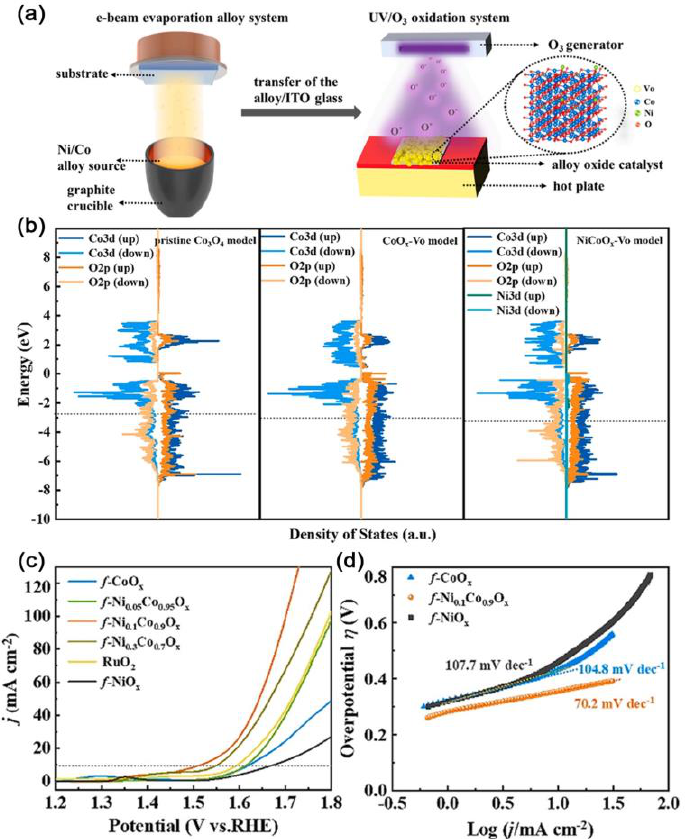
Figure 11. ( a ) Schematic illustration of the synthetic process of f − Ni 0.1 Co 0.9 O x film. ( b ) The diagram of PDOS. Electrochemical OER performance assessments without any ohm compensation. ( c ) Polar- ization curves of Ni/Co alloy oxides. ( d ) Tafel plots. Reproduced with permission from ref. [119]. Copyright 2021, Elsevier B.V.